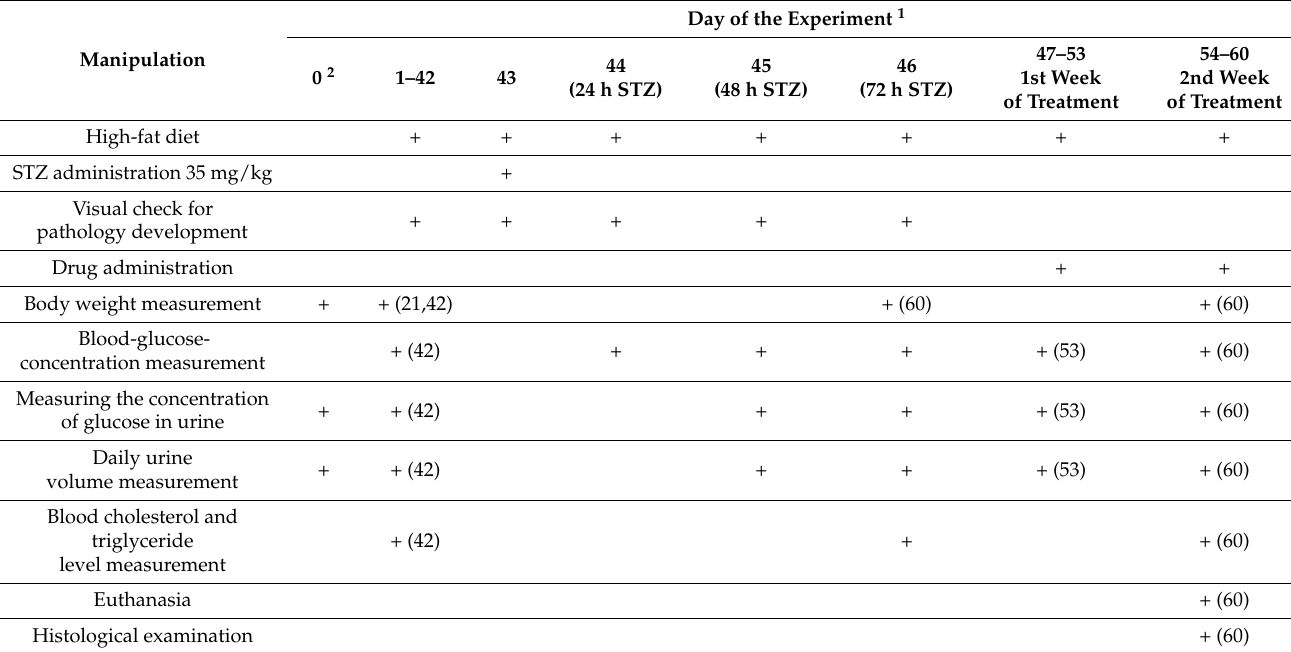
Table 1. Experimental design to investigate hypoglycemic activity of cell biomass of D. deltoidea and T. terrestris , using Type 2 diabetes model (T2DM).